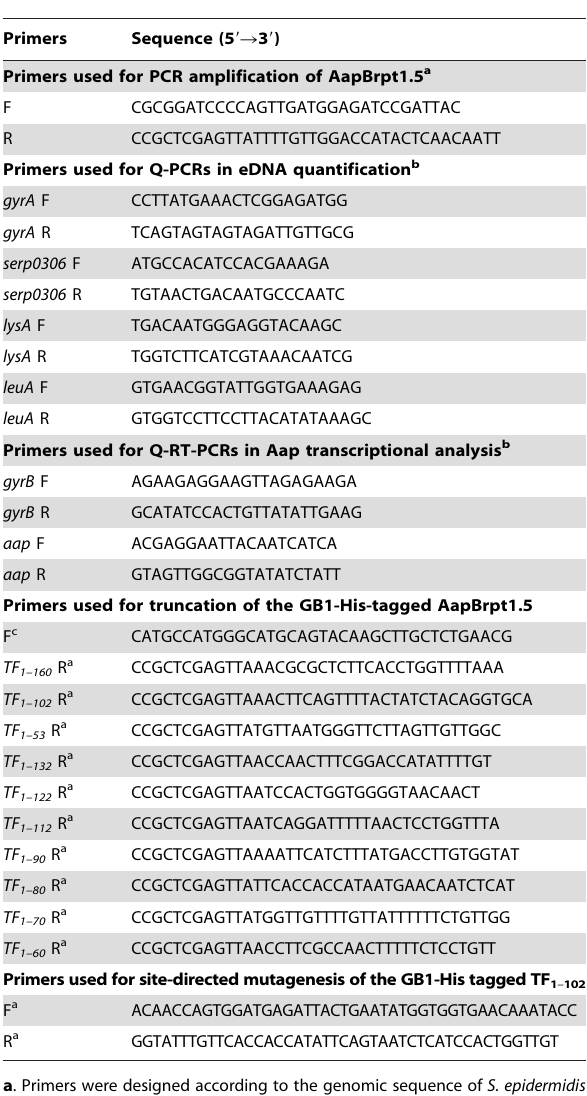
Table 5. Oligonucleotide primers used in the present